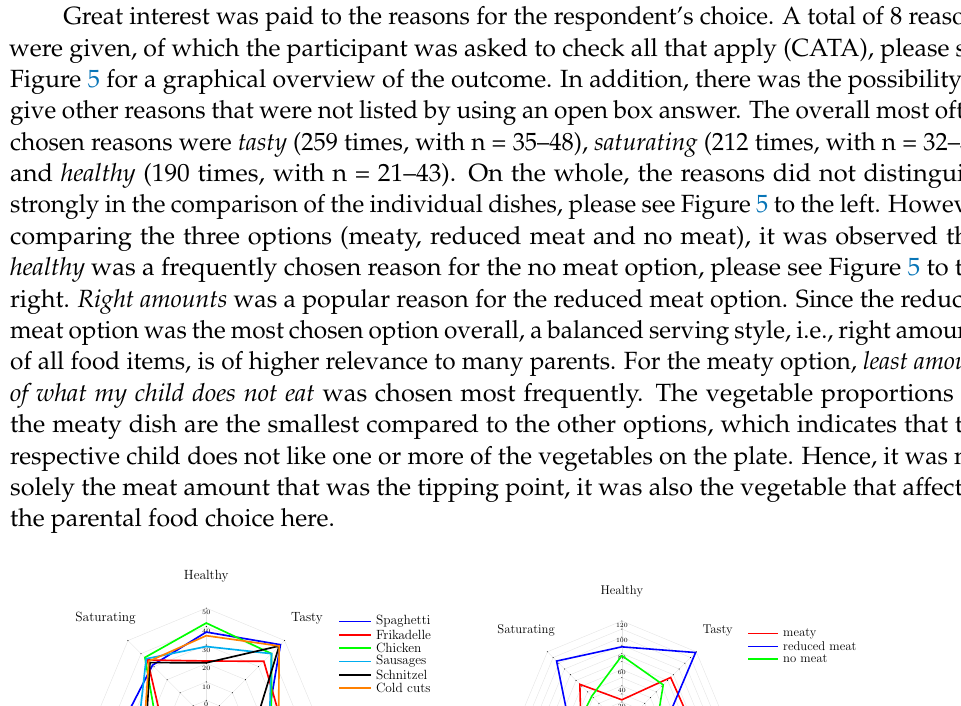
Frikadelle: p = 0.008, chicken drumsticks: p = 0.012, sausages: p = 0.029, Schnitzel: